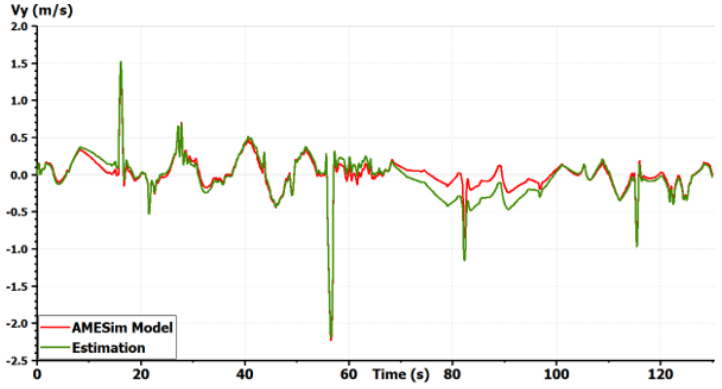
Figure 7. Validation of the vehicle model: lateral speed [10].